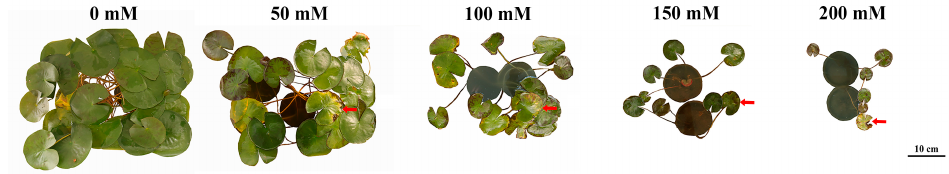
Figure 1. Effect of salt stress on water lily plants. Photos were taken after 30 days of continuous salt treatment. Leaf chlorosis and decay are marked with red arrows.